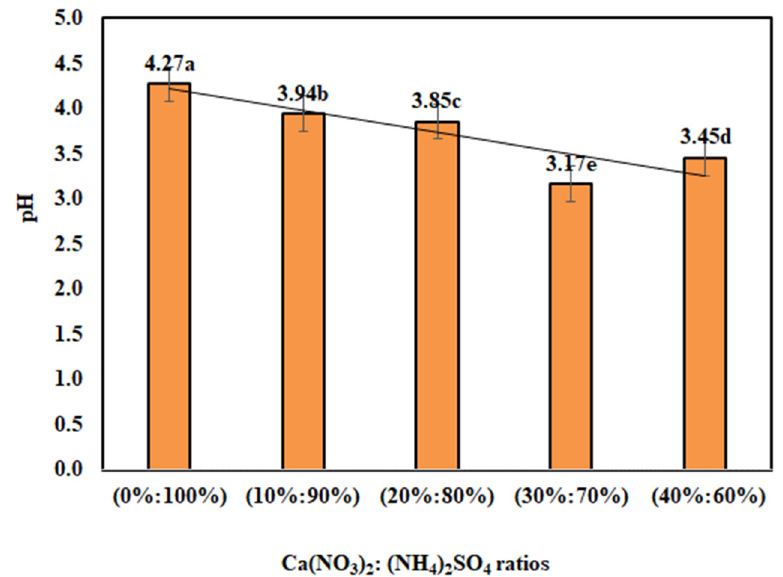
Figure 1. Impact of Ca(NO 3 ) 2 :(NH 4 ) 2 SO 4 ratios on average values of juice pH of the two years. Significant differences ( p < 0.05) are denoted by values in the same column that are marked with distinct letters.